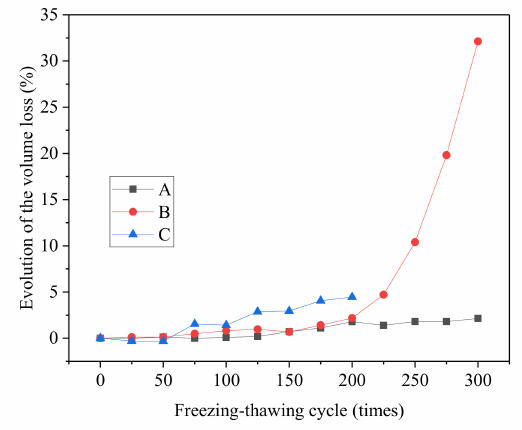
Figure 11. Evolutionary rules of volume loss rates of different